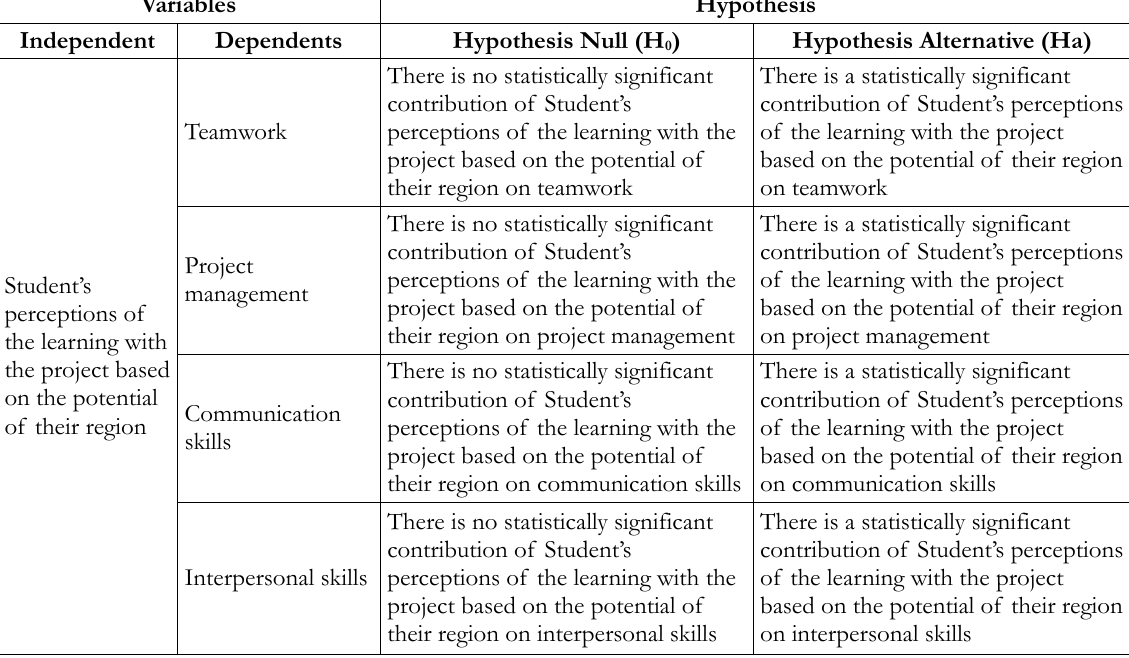
Table 2. Variables